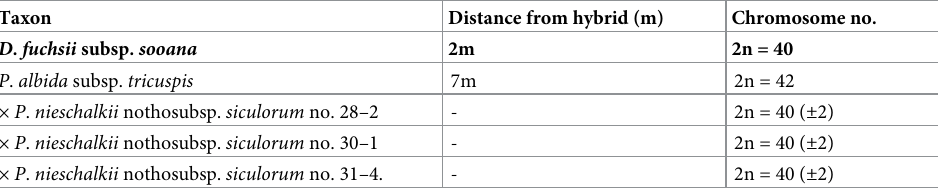
Fig 14. Chromosomes at somatic metaphase (Feulgen staining) of × Pseudorhiza nieschalkii nothosubsp. siculorum hybrid 2n = 40 ( ± 2), no. 28–2 (Fig 12); no. 30–1 (Fig 13); no. 31–4 (Fig 14). Scale bar = 1 μ m. https://doi.org/10.1371/journal.pone.0241733.g014 millimetres deep. Lateral lobes only slightly recurved, presenting partial margin crenulation. Labellar base colour yellow with a greenish tinge at spur base, while labellar surface became gradually pure white. Markings comparatively low-contrast pink dots and streaks, covering the central region of labellum and the three lobes. Markings never form continuous loops. midway along length, slightly down-curved, shorter than the ovary. Lateral sepals lightly Table 2. Chromosome numbers of the specimens